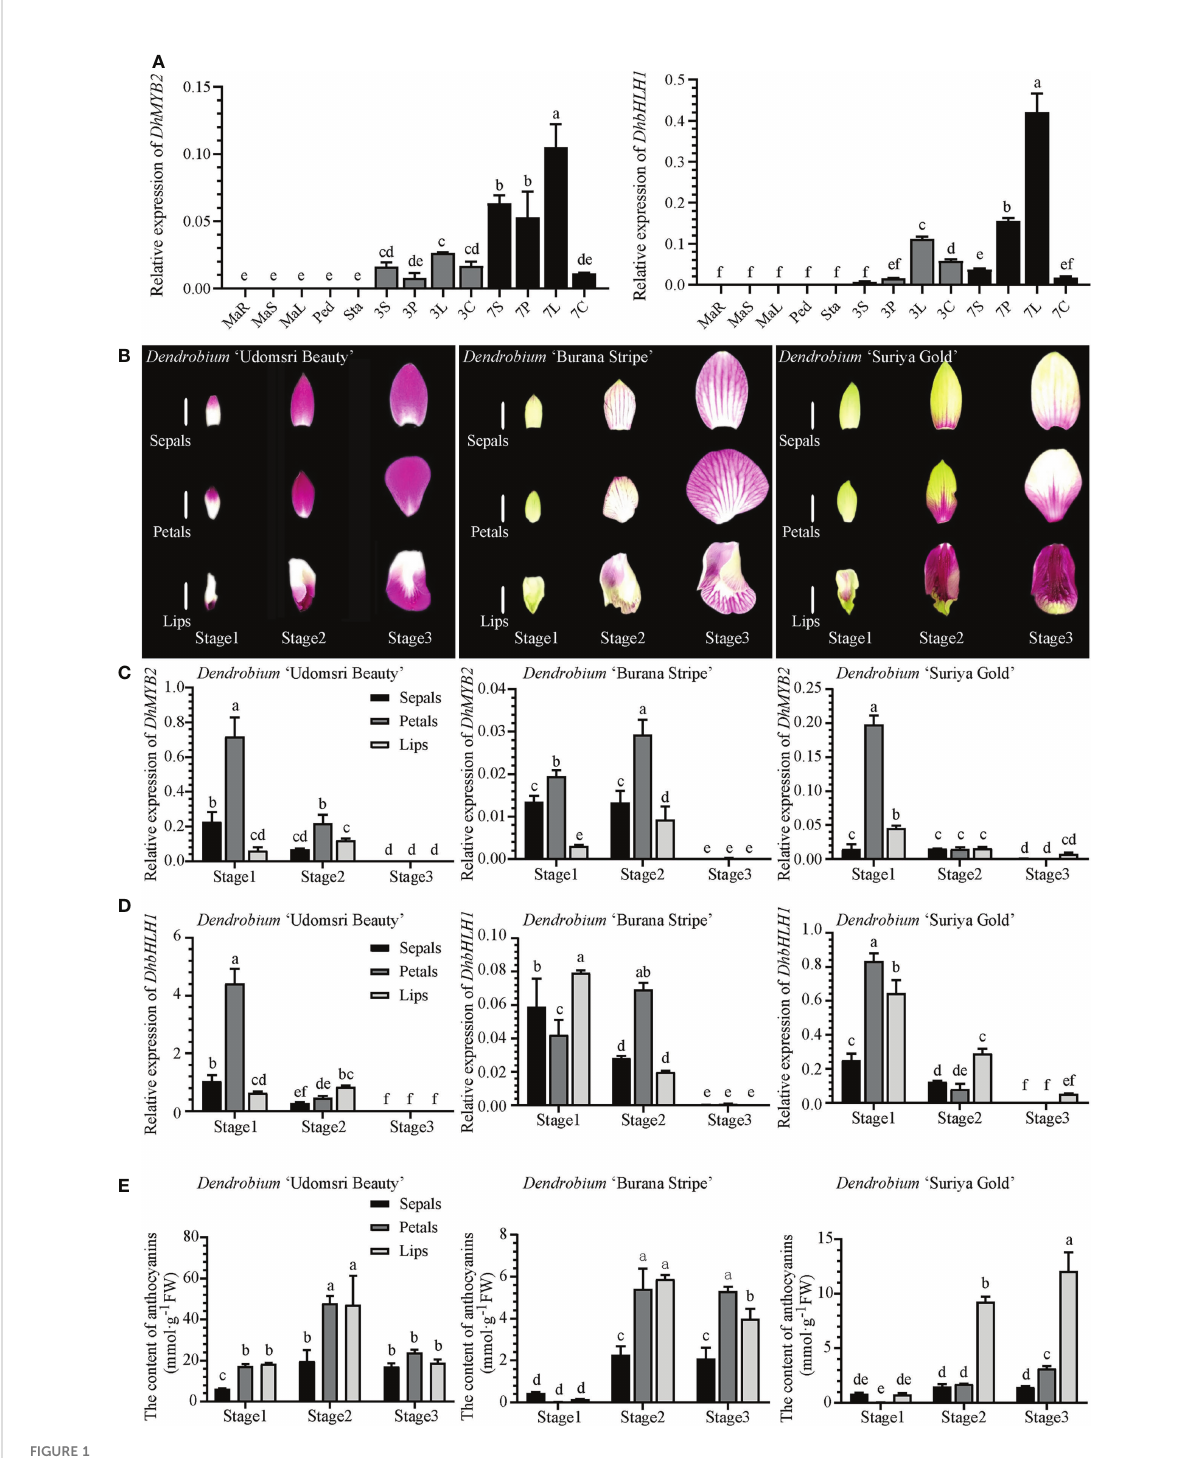
FIGURE 1 Expression patterns of DhMYB2 and DhbHLH1 in different Dendrobium cultivars. (A) Tissue speci fi c expression patterns of DhMYB2 and DhbHLH1 in D. ‘ Sonia Hiasakul ’ . MaR , Mature roots; MaS , Mature stems; MaL , Mature leaves; Ped , Pedicels; Sta , Stalks; 3S , sepals of 3 mm buds; 3P , petals of 3 mm buds; 3L , lips of 3 mm buds; 3C , stamens of 3 mm buds; 7S , sepals of 7 mm buds; 7P , petals of 7 mm buds; 7L , lips of 7 mm buds; 7C , stamens of 7 mm buds. (B) Floral color phenotypes in three developmental stages of D. ‘ Udomsri Beauty ’ , D. ‘ Burana Stripe ’ and D. ‘ Suriya Gold ’ , Bar=1.0 cm. RT-qPCR expression analyses of DhMYB2 (C) and DhbHLH1 (D) , and anthocyanin content (E) of different fl oral tissues of D. ‘ Udomsri Beauty ’ , D. ‘ Burana Stripe ’ and D. ‘ Suriya Gold ’ from three developmental stages. RT-qPCR expression values are expressed as mean -dCt (Ct reference - Ct target) ± SEM from three biological replicates using actin as an internal control for normalization. Different letters indicate signi fi cant differences ( p < 0.05, Duncan ’ s multiple range